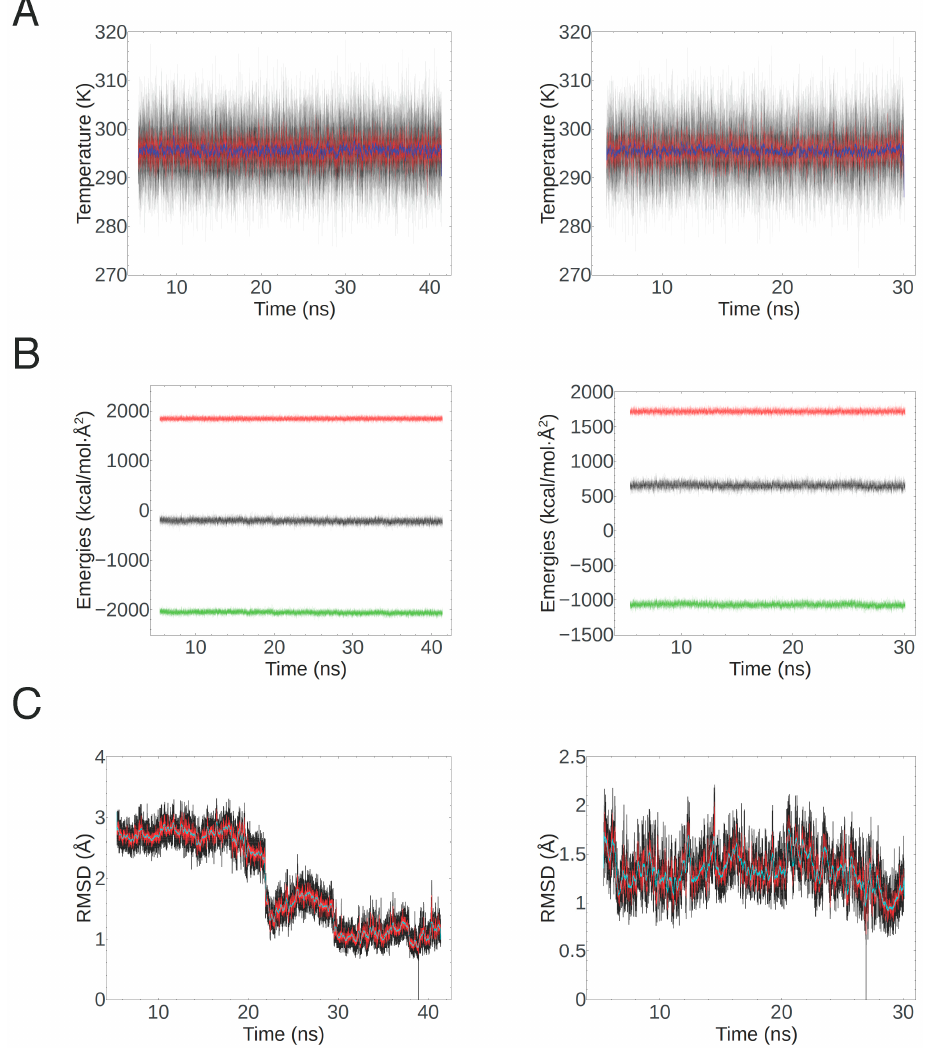
Figure 3. Equilibration and stability of the folded PIN2 helix clusters. ( A ) System temperature of part 1 ( left ) and part 3 ( right ) over the full production run. The raw data are in black, while the red and blue lines show window averages over 10 and 100 ps, respectively; ( B ) Potential energy (green), kinetic energy (red) and total energy (black) of part 1 ( left ) and of part 3 ( right ) over the same period as in ( A ); ( C ) RMSD of the lowest-energy conformation of part 1 ( left ) and part 3 ( right ) with respect to every other frame in the simulation, after alignment (black); the red and light blue lines are window averages over periods of 20 and 200 ps, respectively.